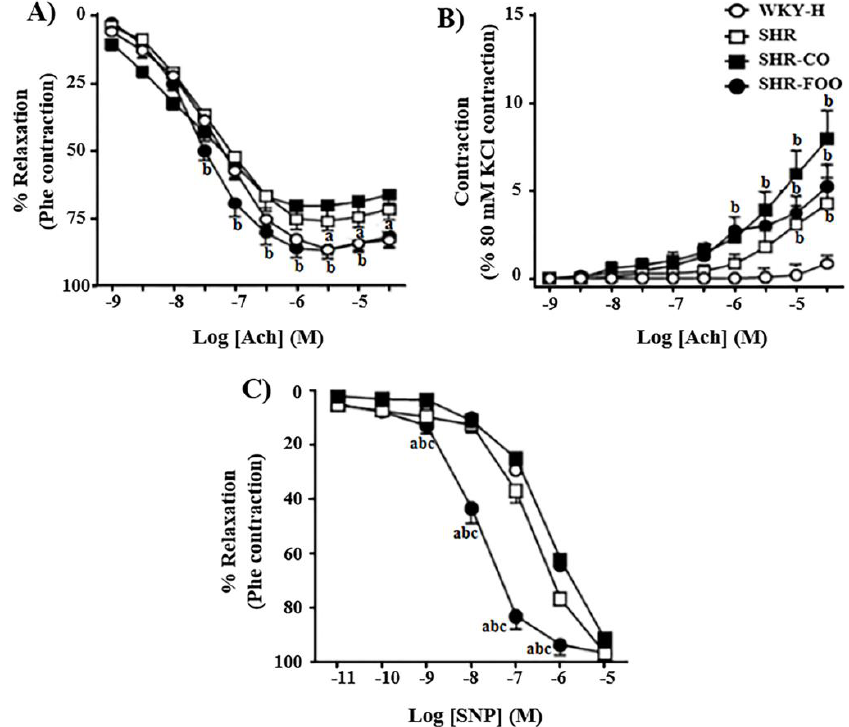
Figure 4. Ex vivo endothelium-dependent vasodilator responses to acetylcholine ( A ), endothelium- dependent vasoconstrictor responses to acetylcholine in the presence of L-NAME (10 − 4 M) ( B ), and endothelium-dependent vasodilator responses to nitroprusside ( C ) in aortic rings. Data are means ± SEM. a p < 0.05 compared with SHR control rats; b p < 0.05 compared with the WKY